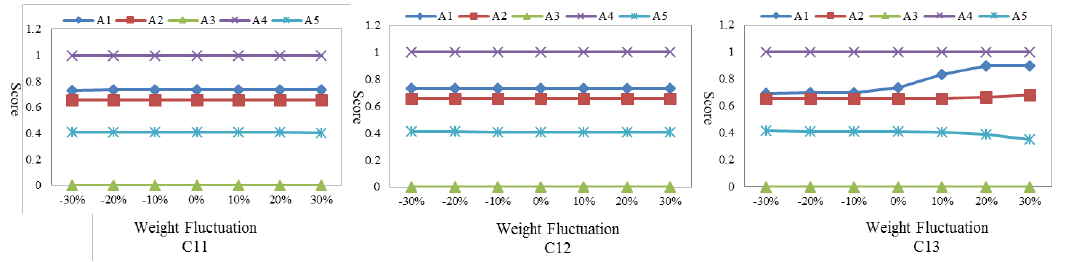
Figure 8. Sensitivity analysis results of the sub-criteria in the technology group.